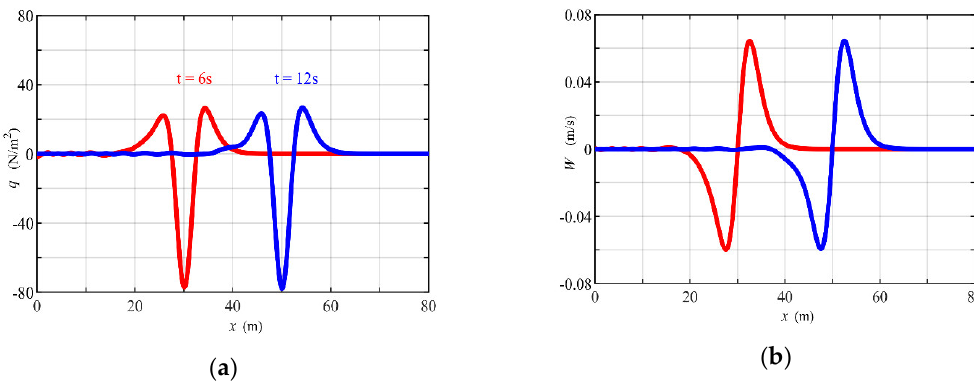
Figure 2. ( a ) Non-hydrostatic pressure and ( b ) vertical velocity at t = 6 and 12 s obtained by the non-hydrostatic shallow-water model.